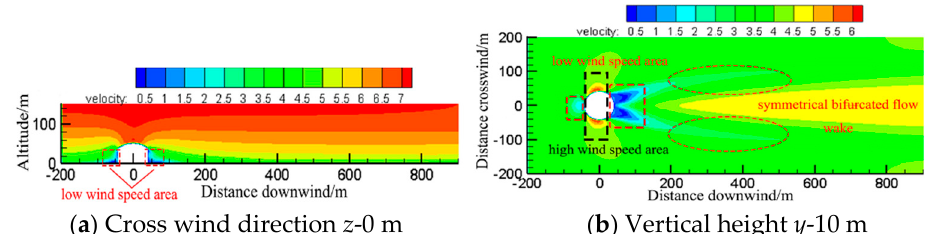
Figure 5. The wind speed in the calculation area.